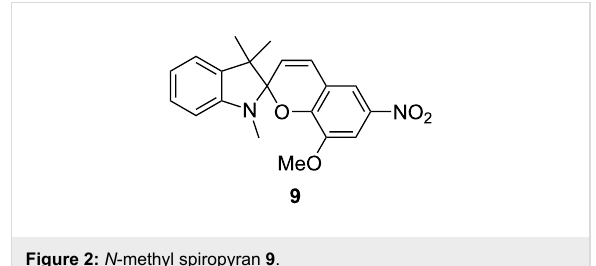
Figure 2: N -methyl spiropyran 9